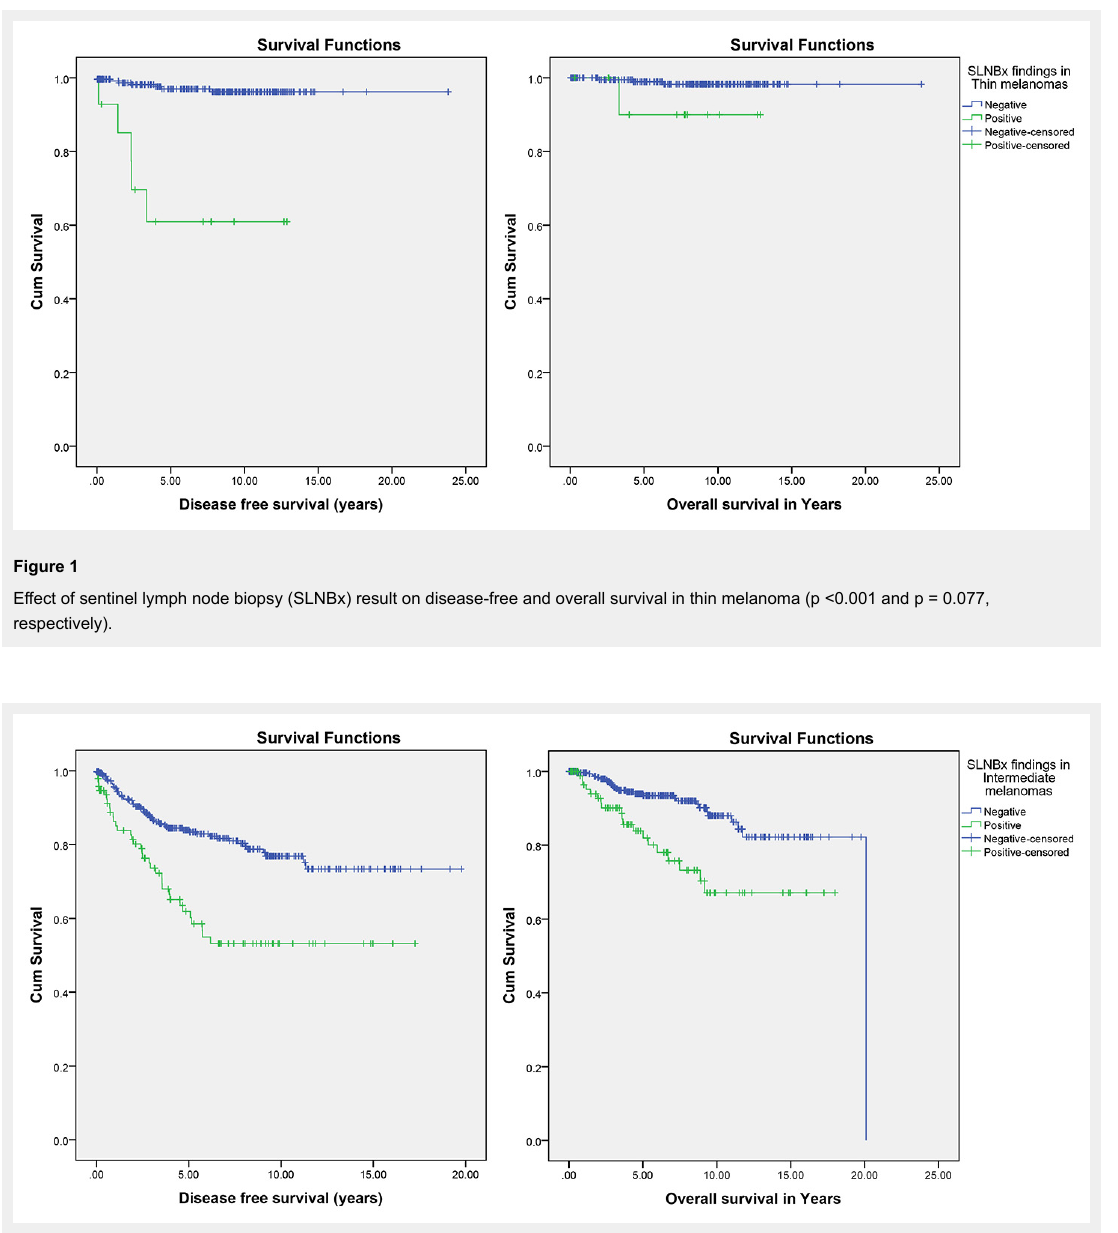
Figure 2 Effect of sentinel lymph node biopsy (SLNBx) result on disease-free and overall survival in intermediate melanoma (p <0.001 and p <0.001,